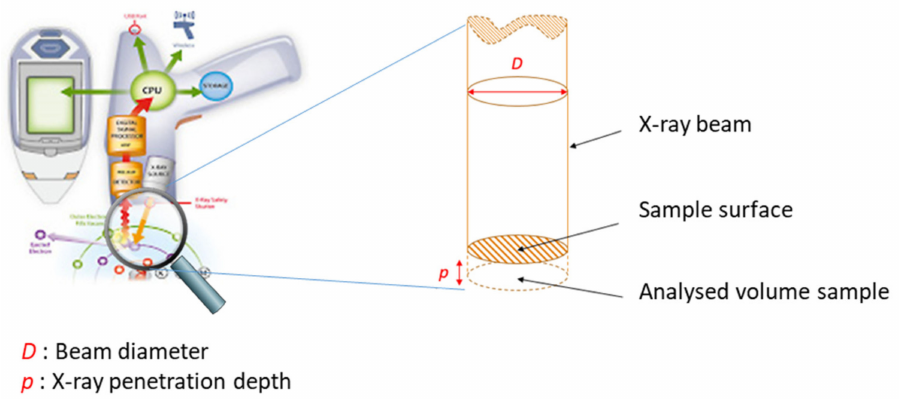
Figure 15. The sample volume actually analysed, according to pXRF instrument geometry (modified from a ThermoFisher